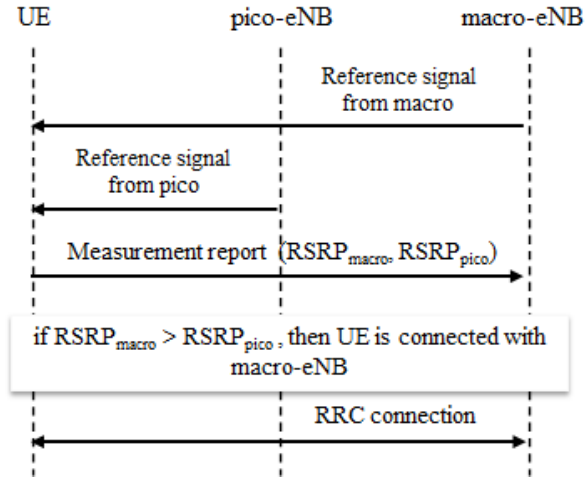
Figure 2. Cell selection procedure based on RSRP in HetNet.